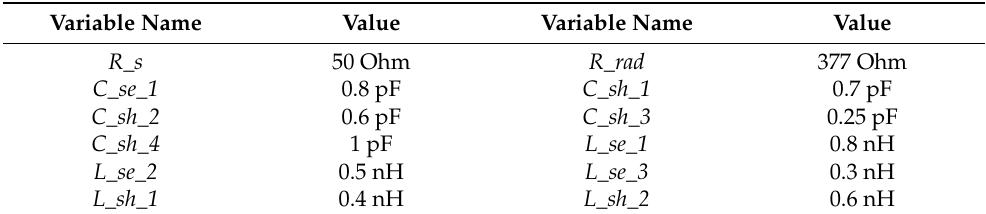
Table 1. The values of the circuit elements of the E-CRLH equivalent